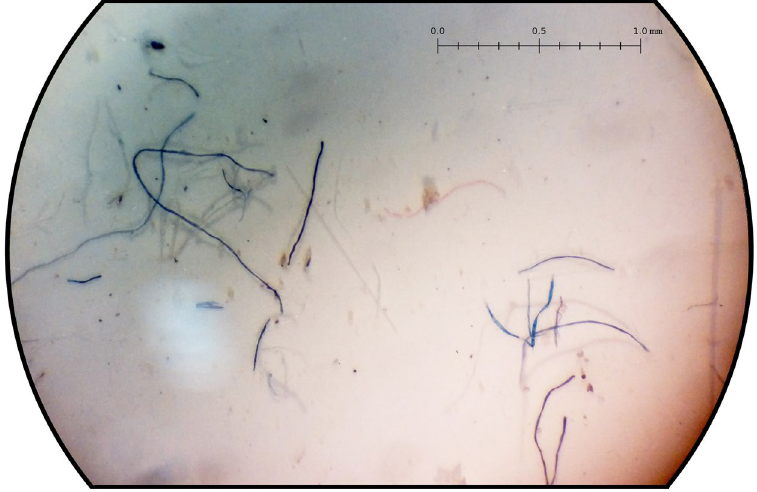
Figure 2. Optical microscope image of a filter after the filtration of a salt sample (The target used was 3.0 ×